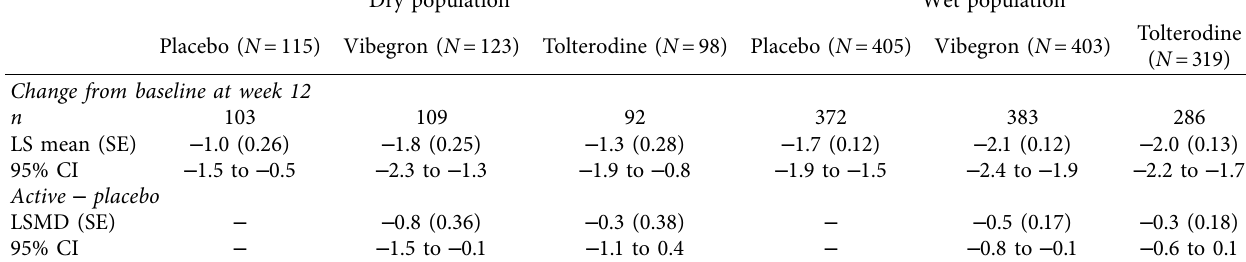
Table 3: Change from baseline at week 12 in mean daily number of micturitions †